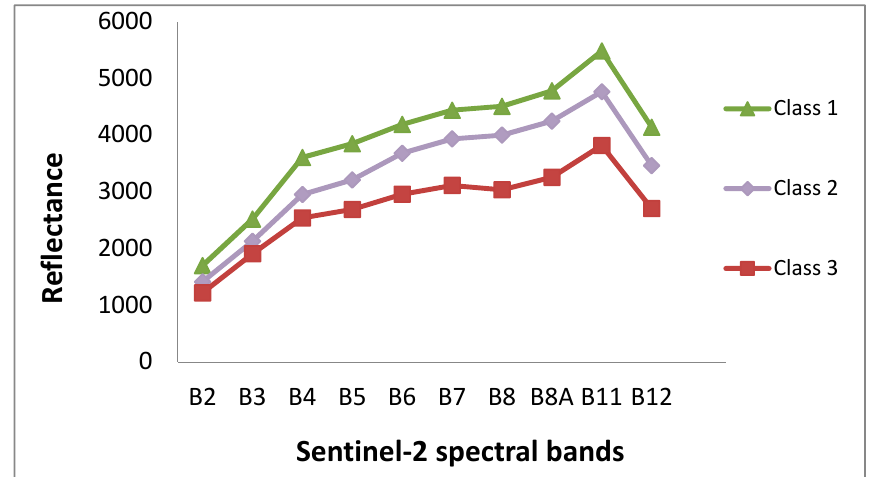
Figure 4. Soil reflectance observed in the Sentinel-2 (S-2) spectral bands, for three different soil textures (distinguished by different ranges of clay content) on the Kairouan Plain site : Class 1 (15 – 30 %), Class 2 (30 – 45 %) and Class 3 (45 – 60 %).